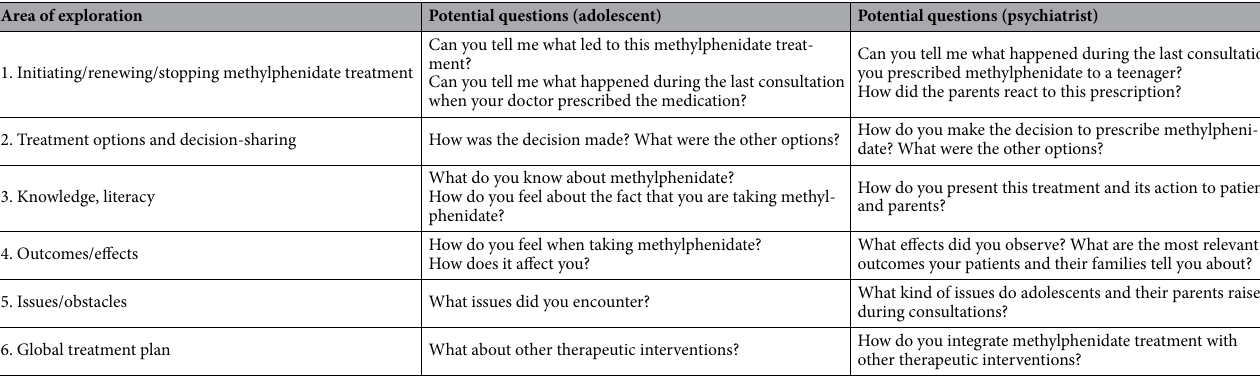
Table 2. Interview guide. The guide was translated from French to English for the sole purpose of this